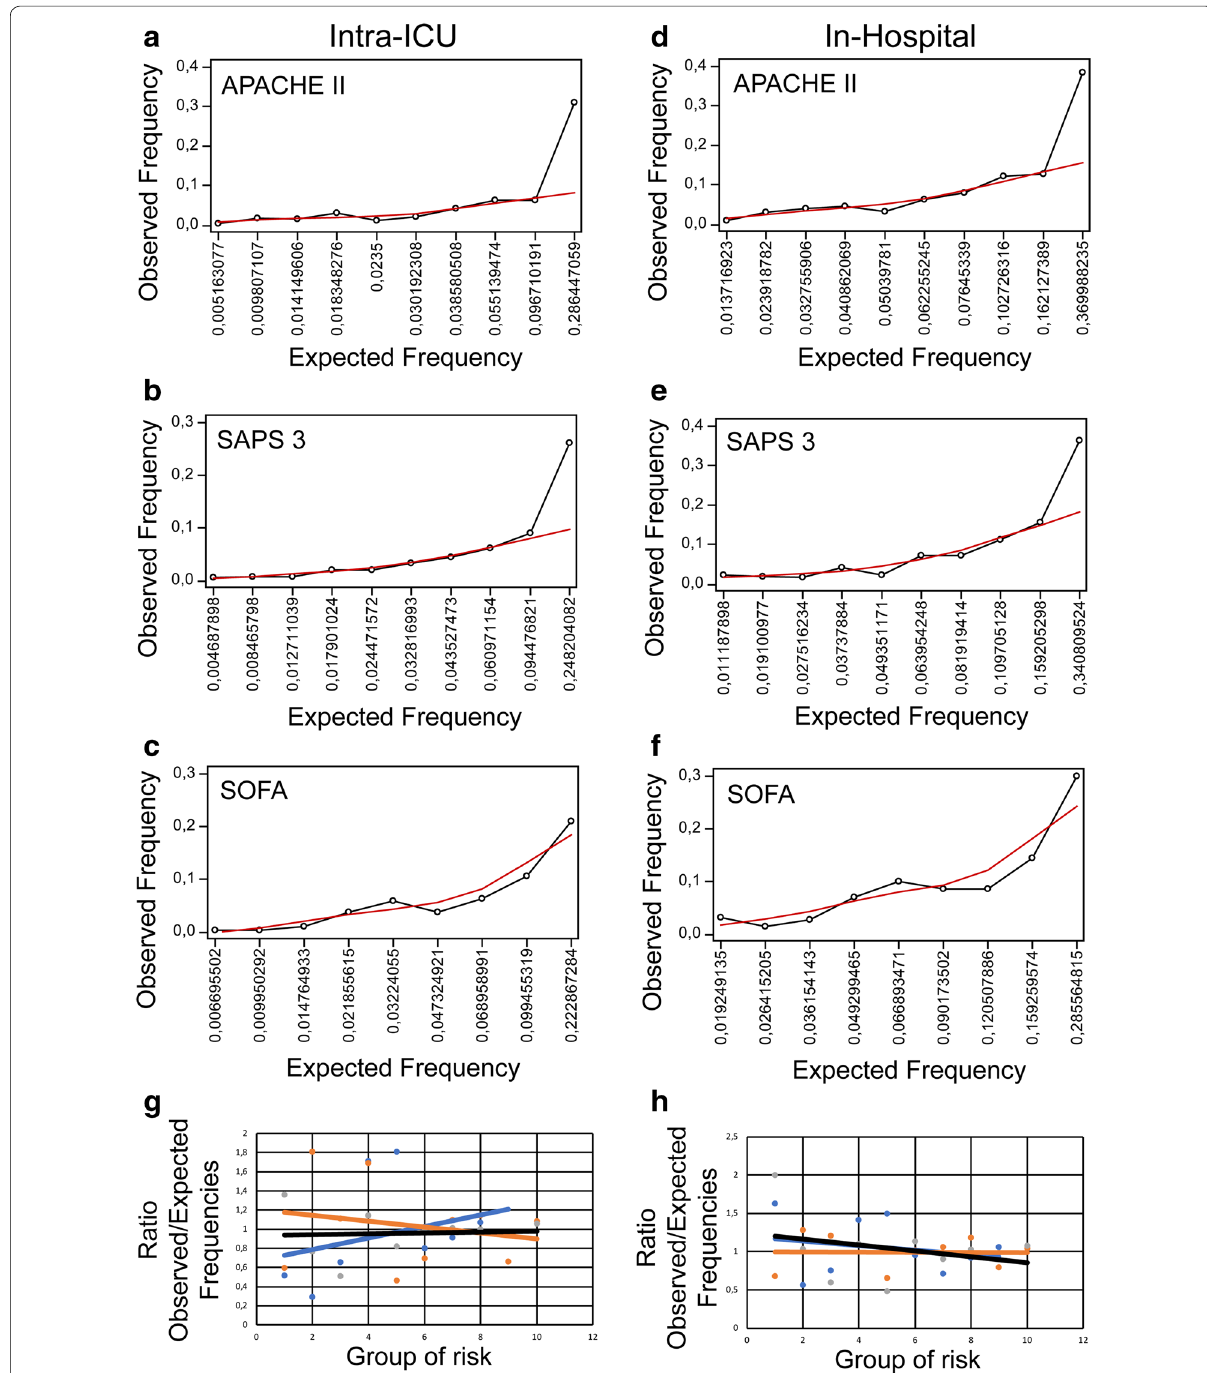
Fig. 3 Prediction models calibration plots. a – f Groups covering the entire predicted intra-ICU ( a – c ) or in-hospital ( d – f ) mortality probabilities calculated by each severity score (on the x -axis) plotted against observed frequencies (on the y -axis) (Dots linked by the black line). A LOWESS line (red), spanning 75% of local values, was created for each dataset to clarify the relationship between assessed variables and to shed light on the direction and magnitude of model miscalibration across the probability range. g , h The ratios of observed over expected intra-ICU ( g ) or in-hospital ( h ) mortality probabilities, calculated by each prediction model (on the y -axis), were plotted against sequential clusters of risk (on the x -axis) to allow direct comparison between severity scores. Linear trend lines were created to aid in comparison. Orange line—APACHE II; black line—SAPS 3; blue